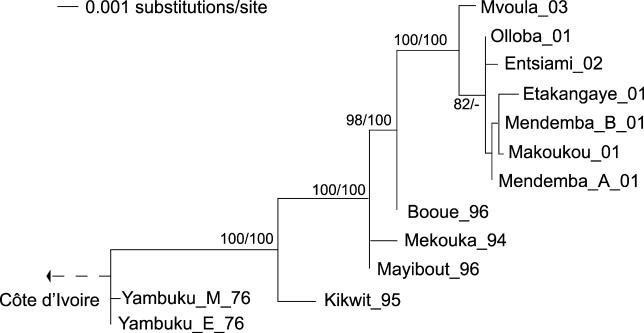
ML Tree of Full-Length (> 2,000 bp) ZEBOV-GP SequencesTree was found in Paup* and rooted in a separate analysis using ICEBOV as an out-group. The latter analysis excluded a 576-bp variable region for which alignment with ZEBOV was uncertain (see Materials and Methods). Numbers next to branches indicate percent support based on 1,000 bootstrap replicates and posterior probabilities obtained in a molecular clock-based analysis in program BEAST (only values > 70% are shown).